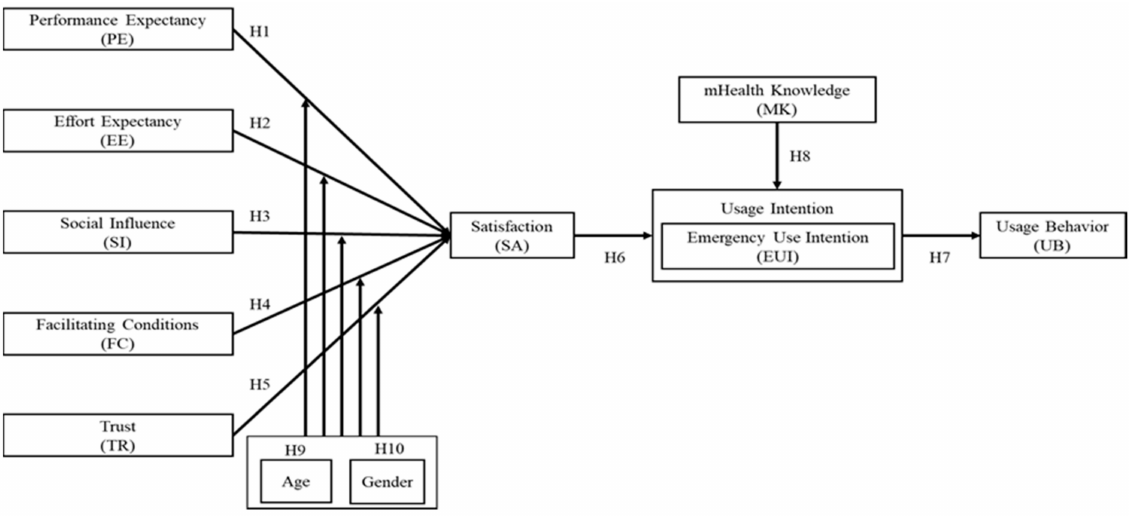
Figure 1. Research